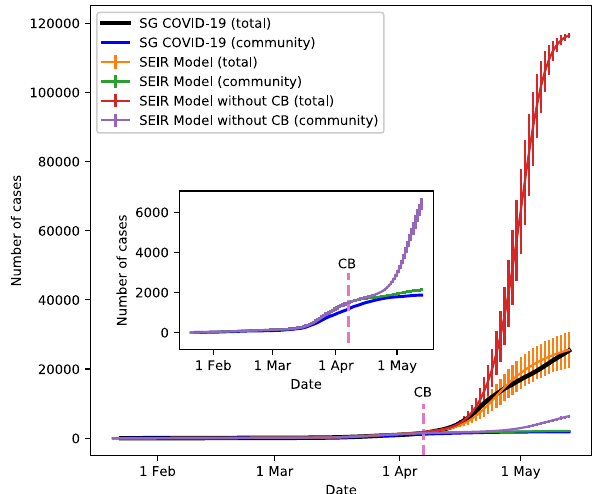
Figure 1. Epidemic curves for the spreading of COVID-19 in Singapore. The curves are shown for the real data, and for the simulated dynamics with and without implementation of the Circuit Breaker (CB) measures. The inset shows an enlarged view of the spreading of COVID-19 within Singapore’s community. Standard deviation is shown as vertical line for the simulated dynamics. Note that the dashed vertical lines in both plots mark the beginning of